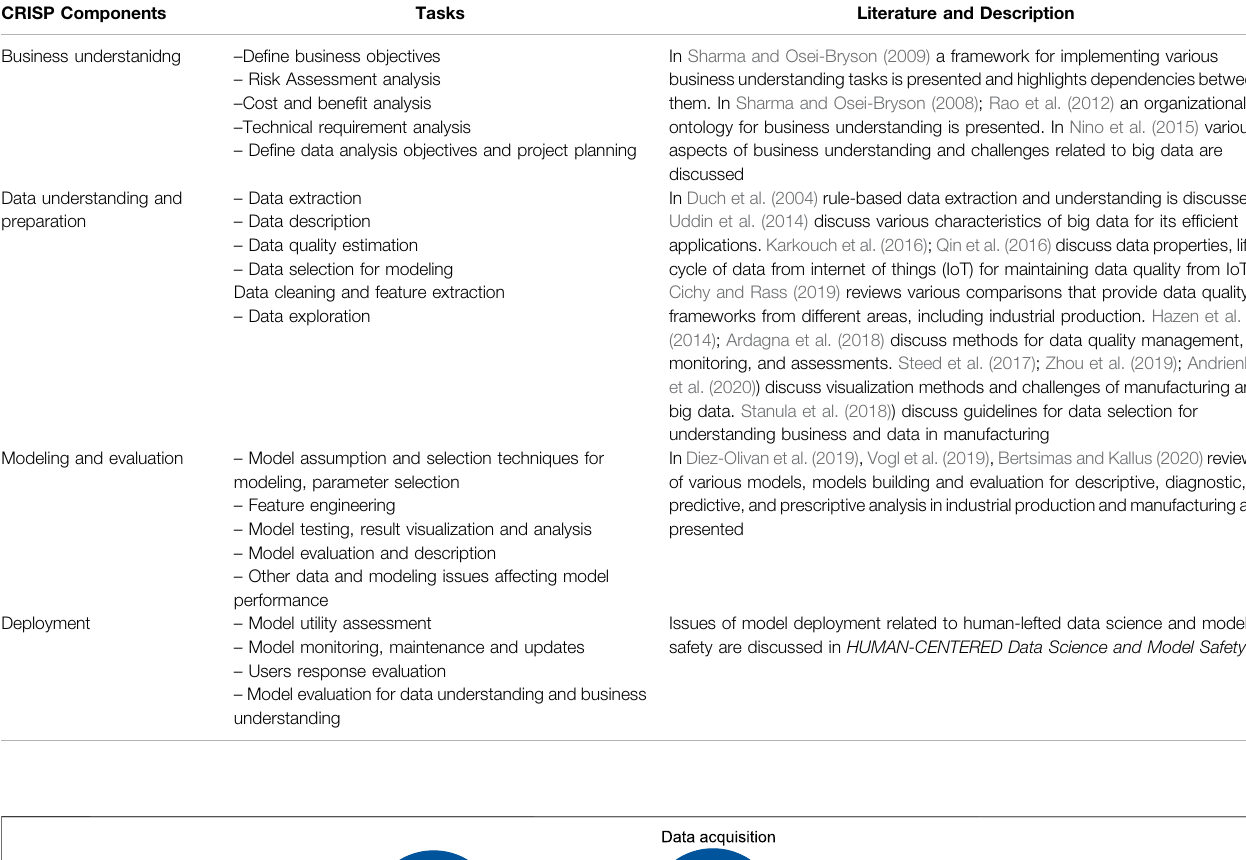
TABLE 1 | Different components of CRISP-DM model and the associated tasks. CRISP Components